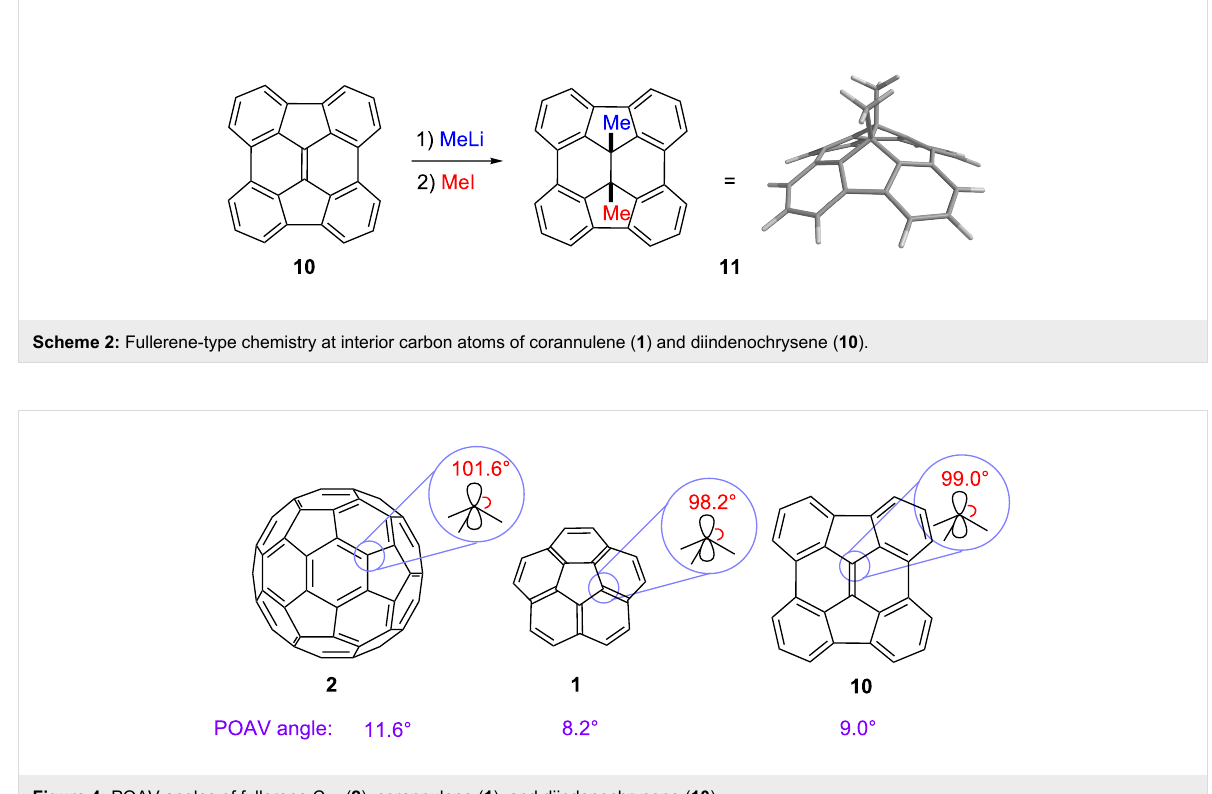
inverts rapidly even at room temperature. The inversion barrier of diindenochrysene ( 10 ) was calculated to be even lower (6.7 kcal/mol at ambient temperature by B3LYP/6-311G**)